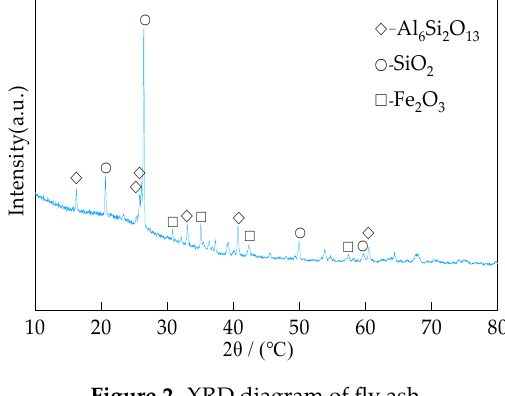
Figure 2. XRD diagram of fly ash. Table 4. Chemical composition of fly ash. Table 1. Physical Indexes of Cement.